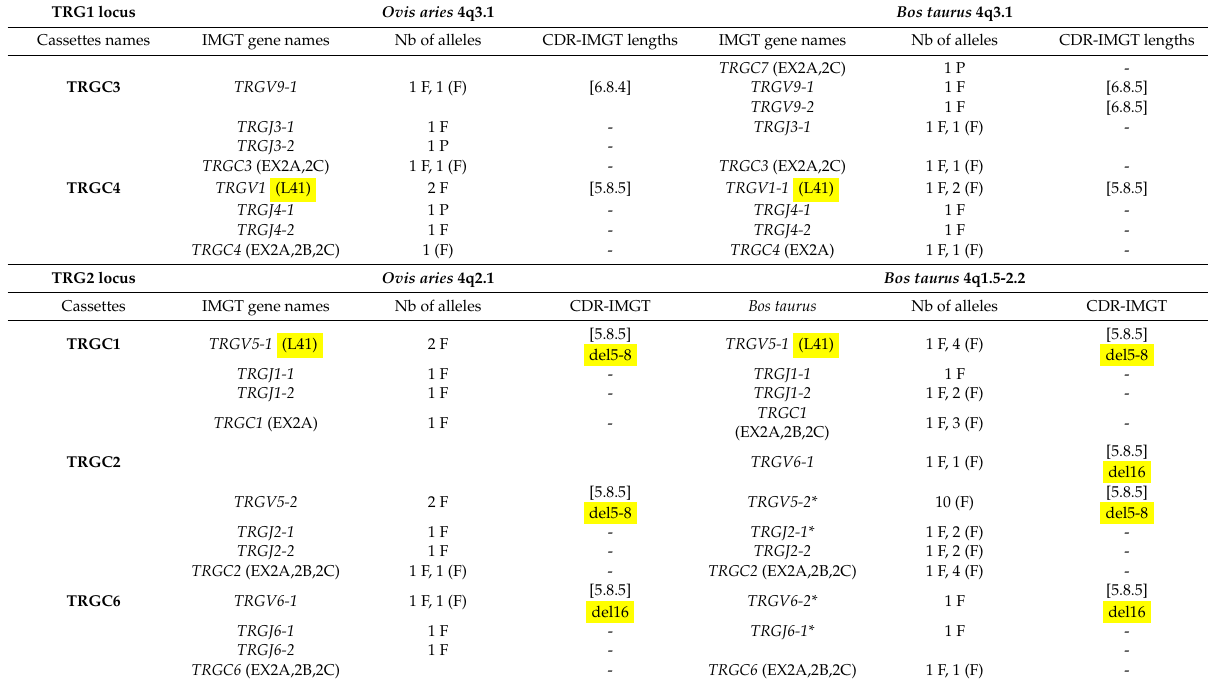
Highlighted (in yellow) are sequence features found in both Ovis aries and Bos taurus TRG sequences (‘del’ followed by numbers indicate gap (unoccupied) positions according to the IMGT unique numbering for V-DOMAIN [58], ‘L41’ indicates that the CONSERVED-TRP 41 is replaced by a leucine (L) in the V-REGION. ‘EX2A’, ‘EX2A,2C’ and ‘EX2A,2B,2C’ indicate exon designation for TRGC gene with 1, 2 or 3 Exons 2,